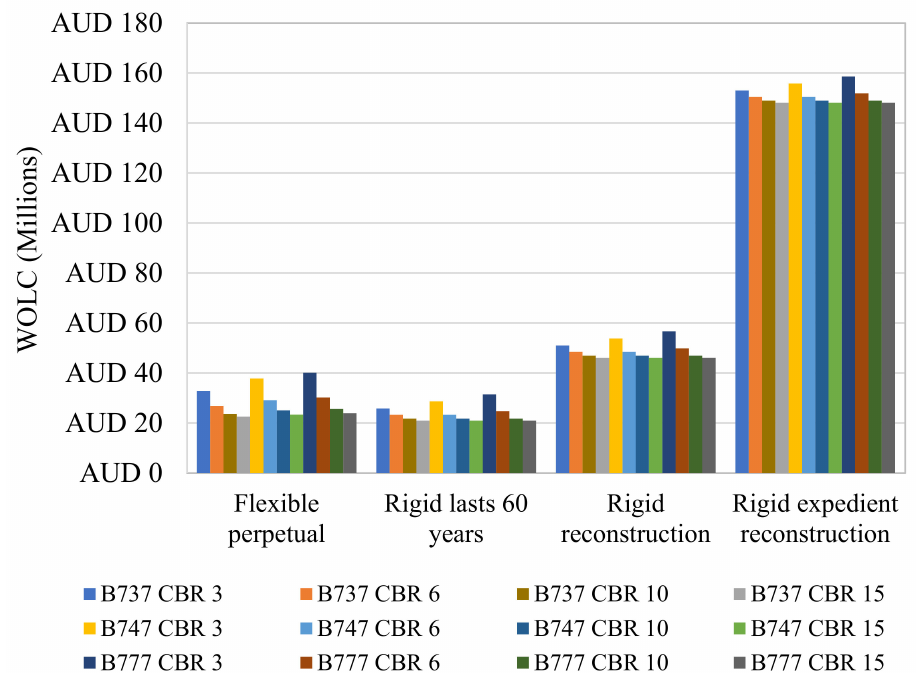
Figure 7. Forty-year WOLC cost for different rigid pavement end of life assumptions.